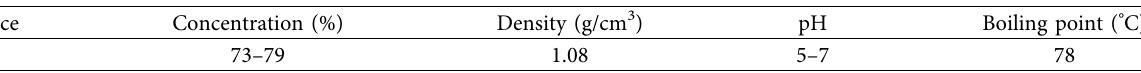
Table 4: Chemical and physical properties of the sodium dodecyl sulfate